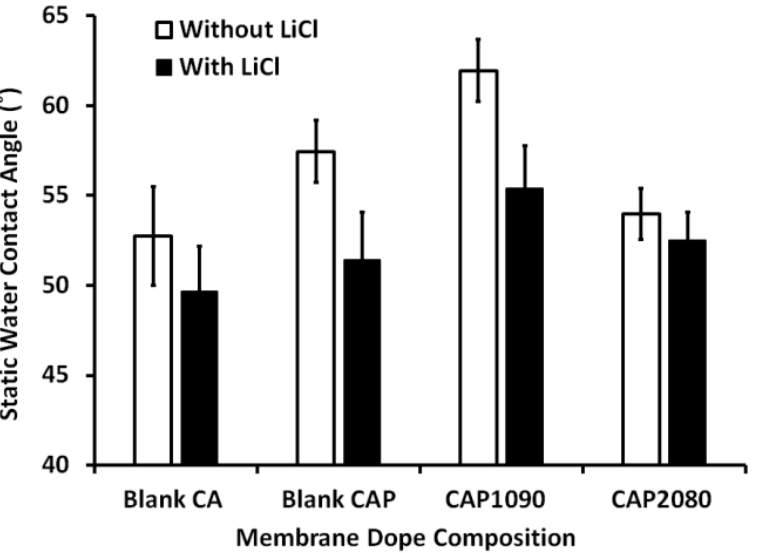
Figure 7. Static water contact angle in the composition of the blank CA and the different magnetic mixed CA matrix membranes in the absence (black bars) and presence (white bars) of 0.1 wt.% of lithium chloride in the membrane dope.